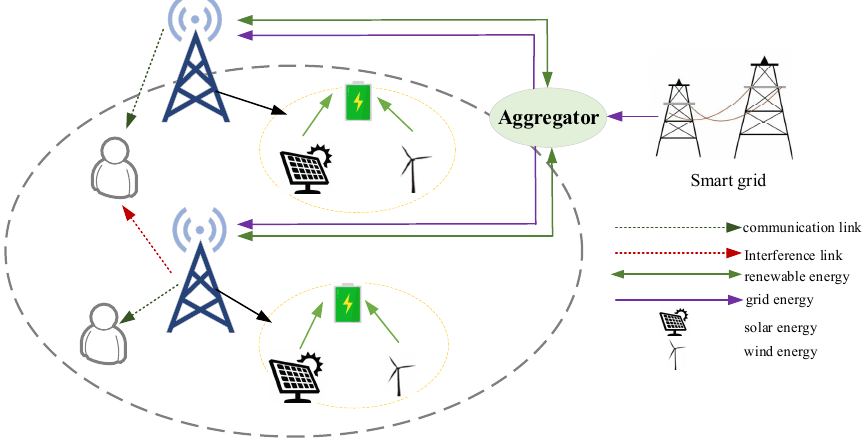
Figure 1. System model.